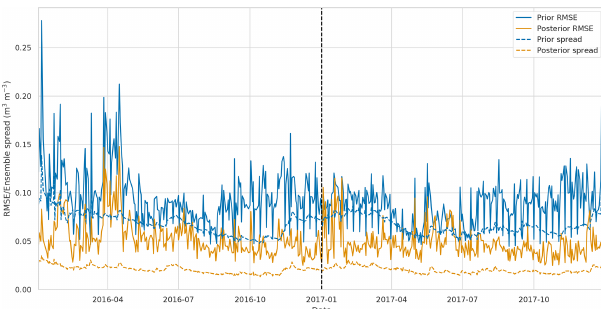
Figure 10. Spatially averaged RMSE and ensemble spread for JULES prior and posterior model estimate. Solid blue line: prior JULES RMSE, dashed blue line: prior JULES ensemble spread, solid orange line: posterior JULES RMSE, dashed orange line: pos- terior JULES ensemble spread. The dotted black line represents the end of the assimilation window and start of the hindcast